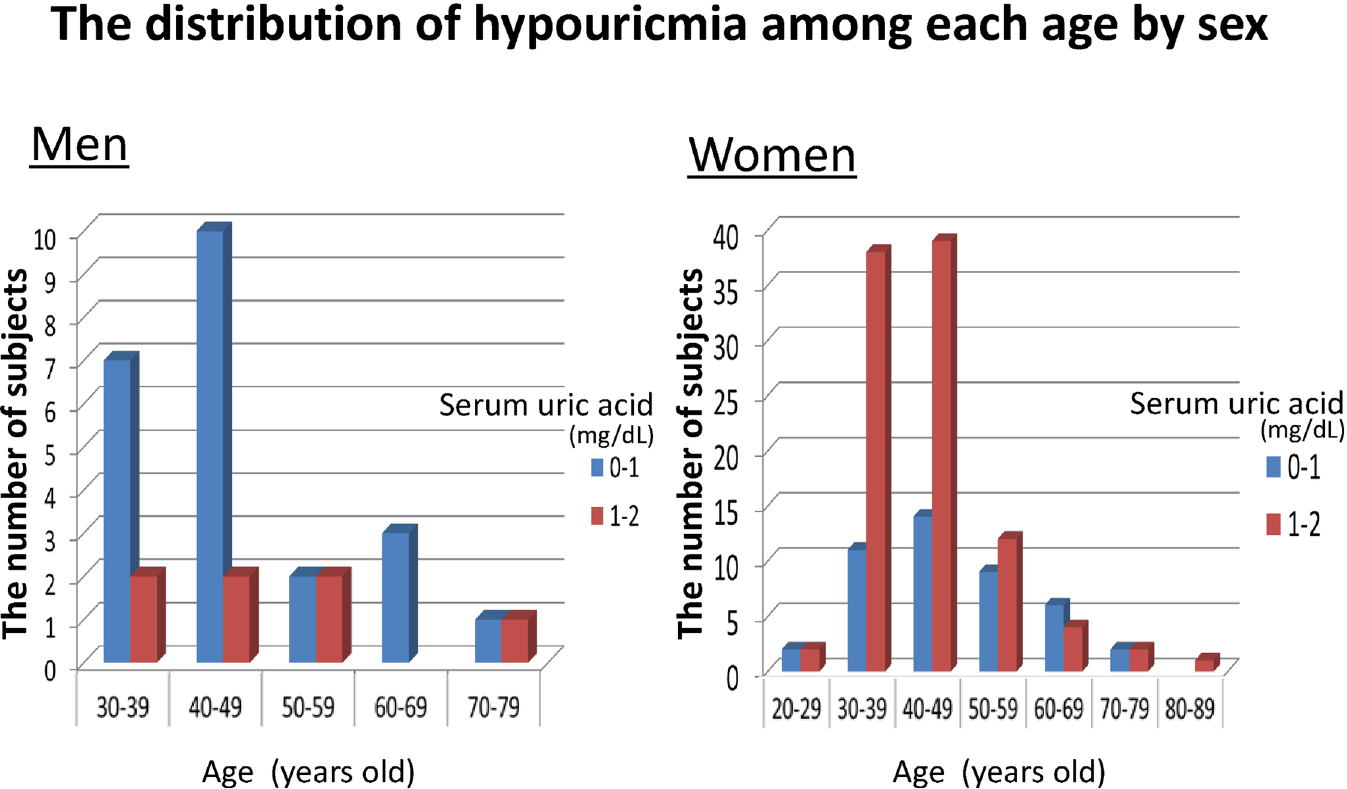
Fig 3. The distribution of hypouricemia among each age by sex. In women, the numberof hypouricemia subjects was decreased with age.